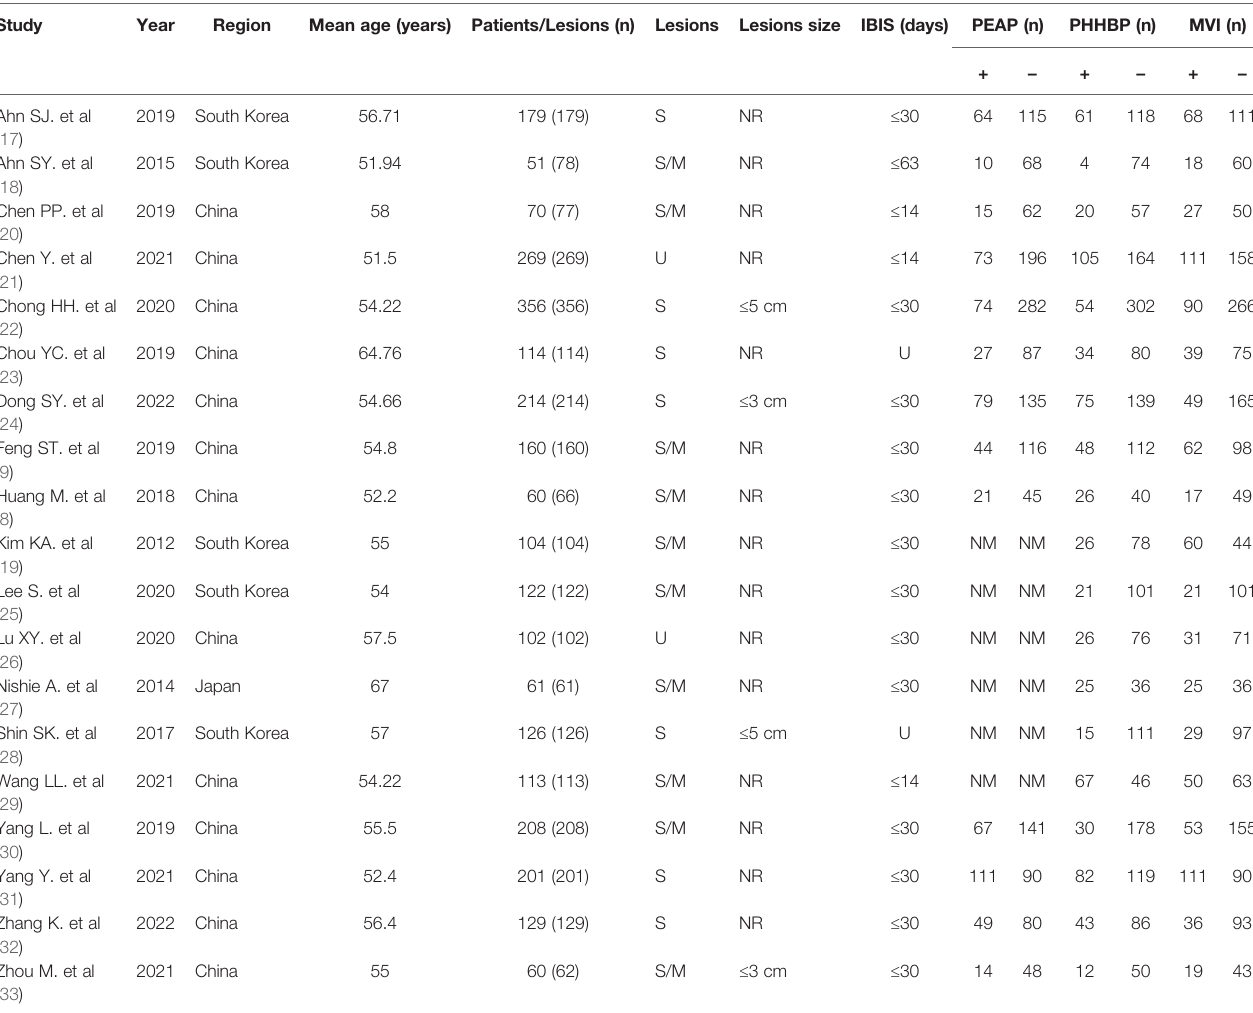
TABLE 1 | Characteristics of the 19 included